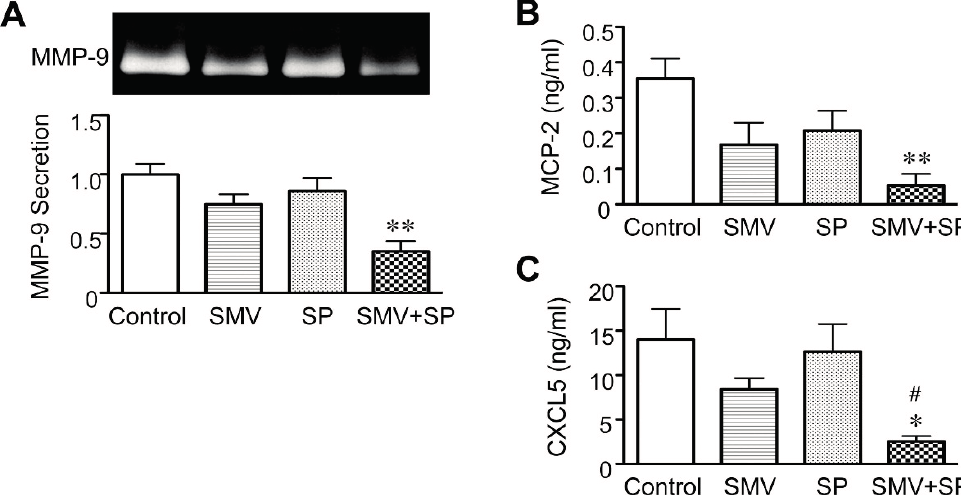
Figure 6. Additive effect of statin and c-jun N -terminal kinase (JNK) inhibitor on human abdominal aortic aneurysm (AAA) wall. A human AAA wall was cut into small pieces and cultured with simvastatin (SMV, 3 μ M), JNK inhibitor SP600125 (SP, 5 μ M) or vehicle (control). ( A – C ) Levels of matrix metalloproteinase (MMP)-9, monocyte chemoattractant protein (MCP)-2 and epithelial neutrophil-activating peptide (CXCL5) in the conditioned media were analyzed ( n = 4). Data are the mean ± standard deviation. * p < 0.05 and ** p < 0.01 compared to the control; # p < 0.05 compared to